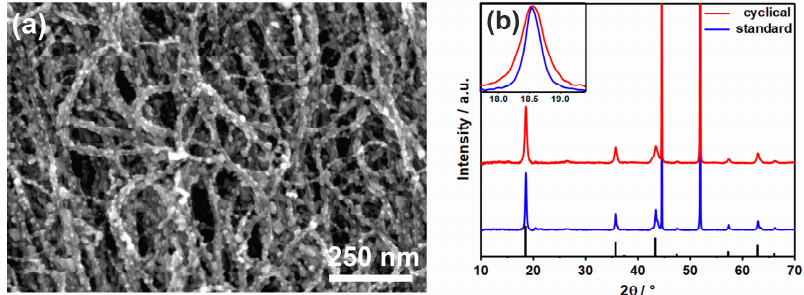
Figure 5. ( a ) SEM image of 70 wt % LTO–VACNT nanoarray synthesized via cyclic infiltration and annealing method; ( b ) XRD pattern of cyclic LTO–VACNT nanoarray in comparison with the